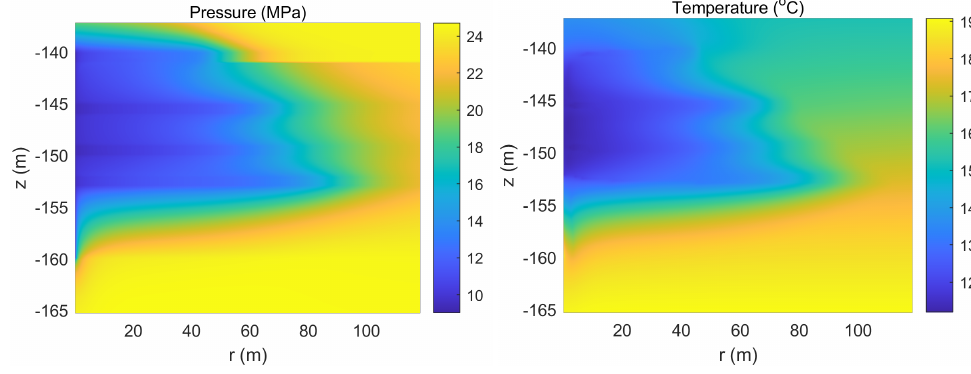
Figure 8. Pressure and temperature distributions after 154-days of production.